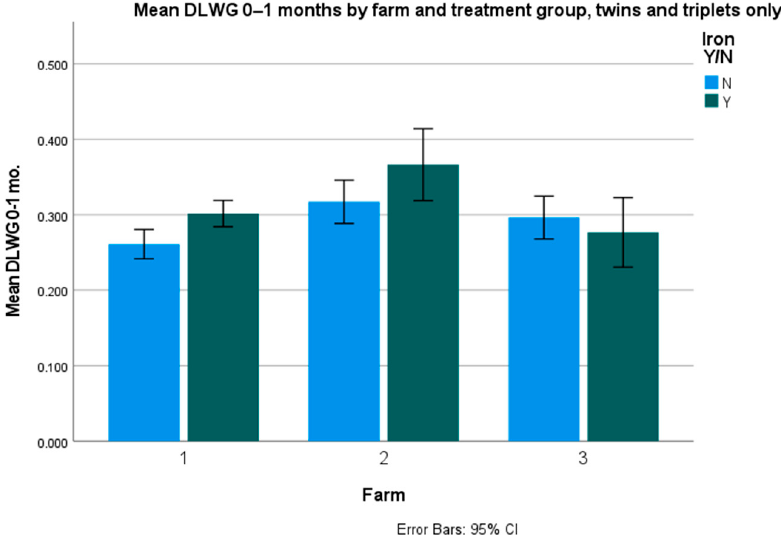
Figure 2. Mean 0–1-month DLWG in twins and triplets (kg/day).